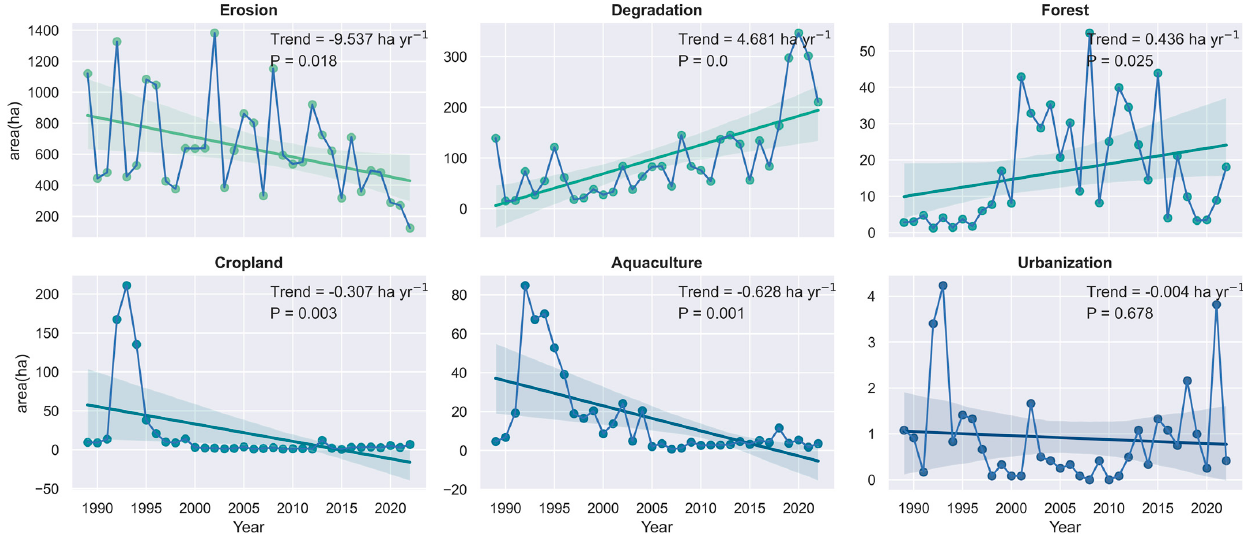
Figure 9. Areas of six casual agents of mangrove losses at an annual step (1989–2022, 1988 as the baseline). The trend and significance were estimated using the Theil–Sen slope estimator and the Mann–Kendall trend test.